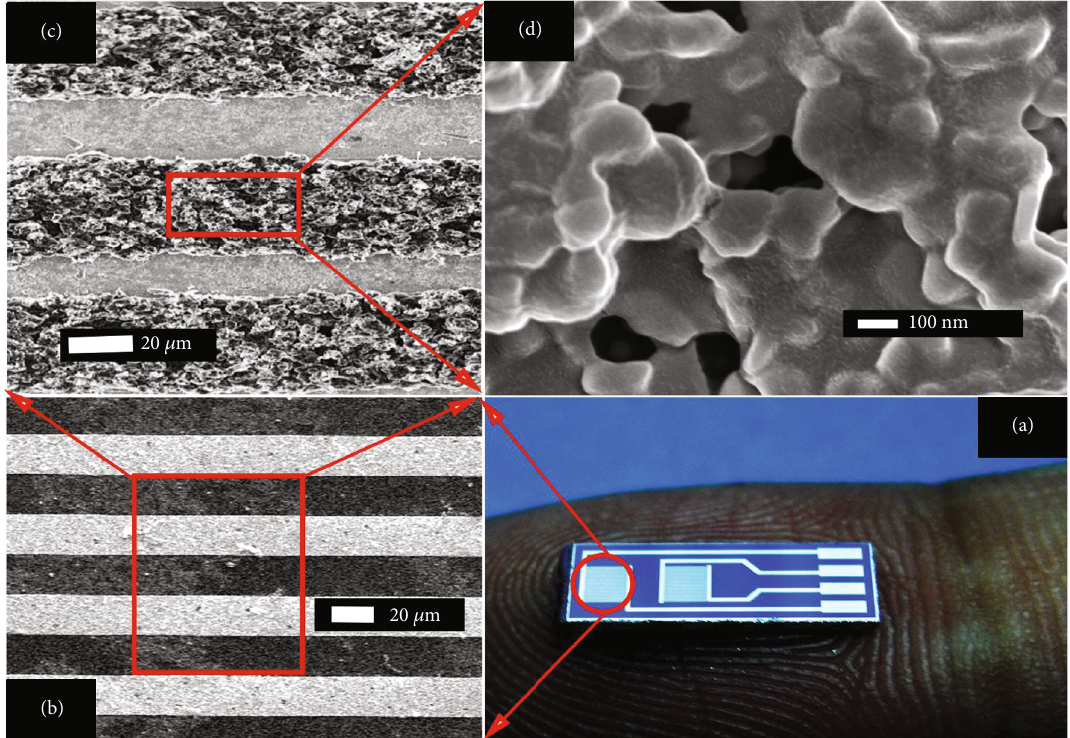
Scheme 1: Schematic of cholesterol biosensor fabrication, (a) microelectrode, and (b) – (d) magni fi cation of CeO modi fi ed